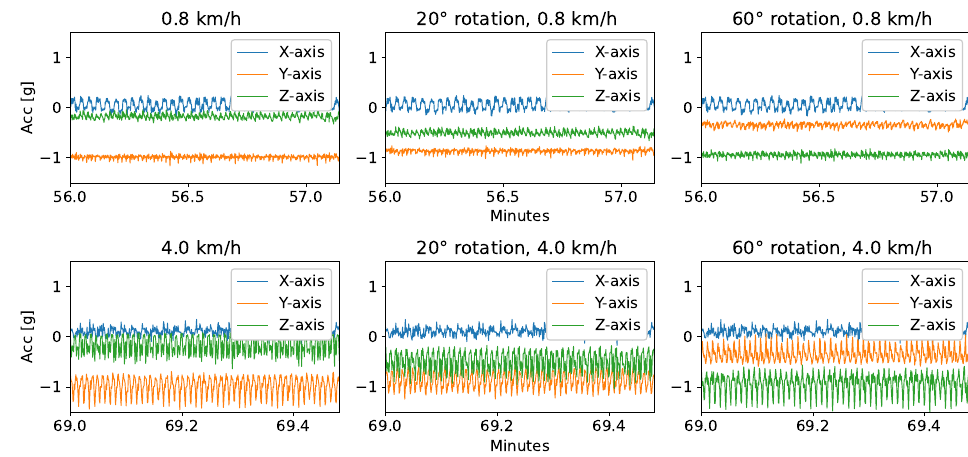
Figure 9. Walking activities of 0.8 km/h (top) and 4.0 km/h (bottom) and the corresponding applied rotations of twenty and sixty degrees ( g = 9.81 km/s 2